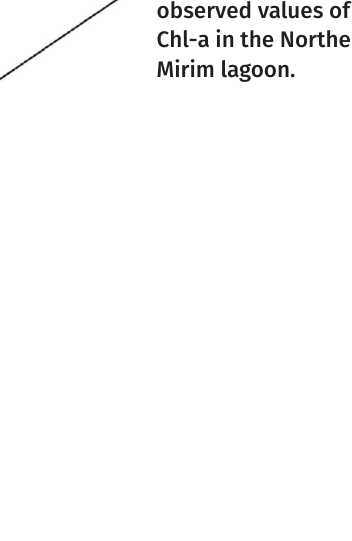
Figure 3. Predicted and observed values of Chl-a in the Northern Mirim